Question: Summarize what this figure shows in one sentence.
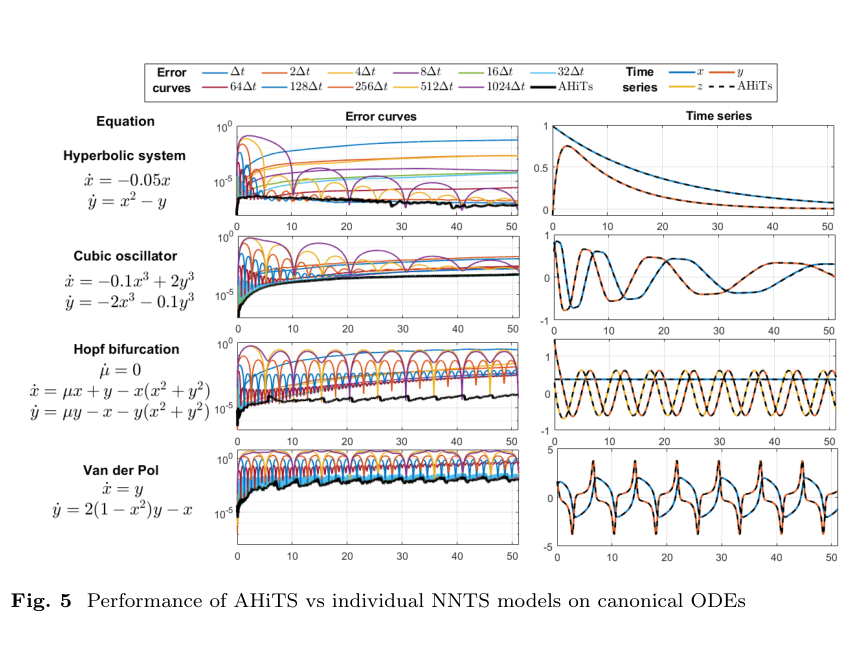
Answer: Performance of AHiTS vs individual NNTS models on canonical ODEs